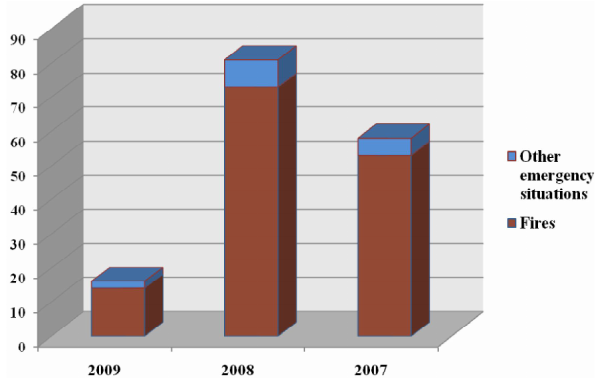
Fig. 10. Emergency response actions in the chemical, petrochemi- cal and rubber Figure 10. Emergency response actions in the chemical, petrochemical and rubber industry 3